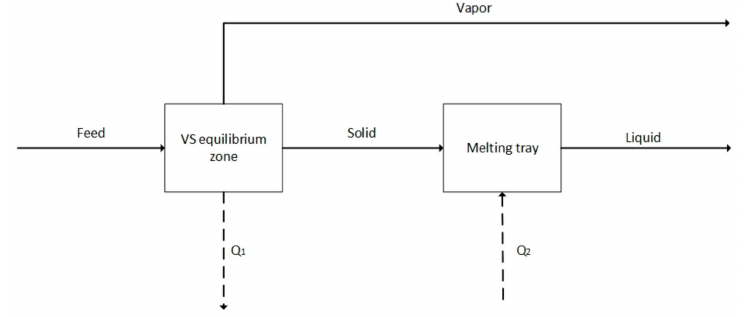
Figure 3. Simplified mass and energy flows for the SV separation